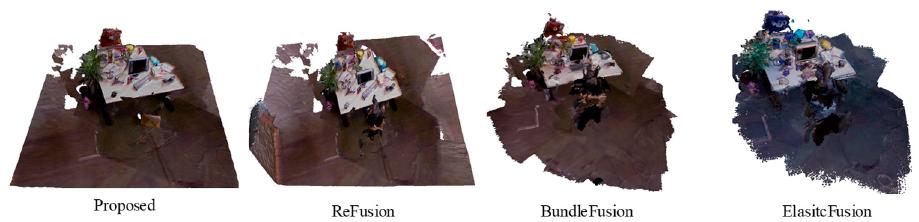
Figure 7. Reconstruction results obtained by four di ff erent methods.